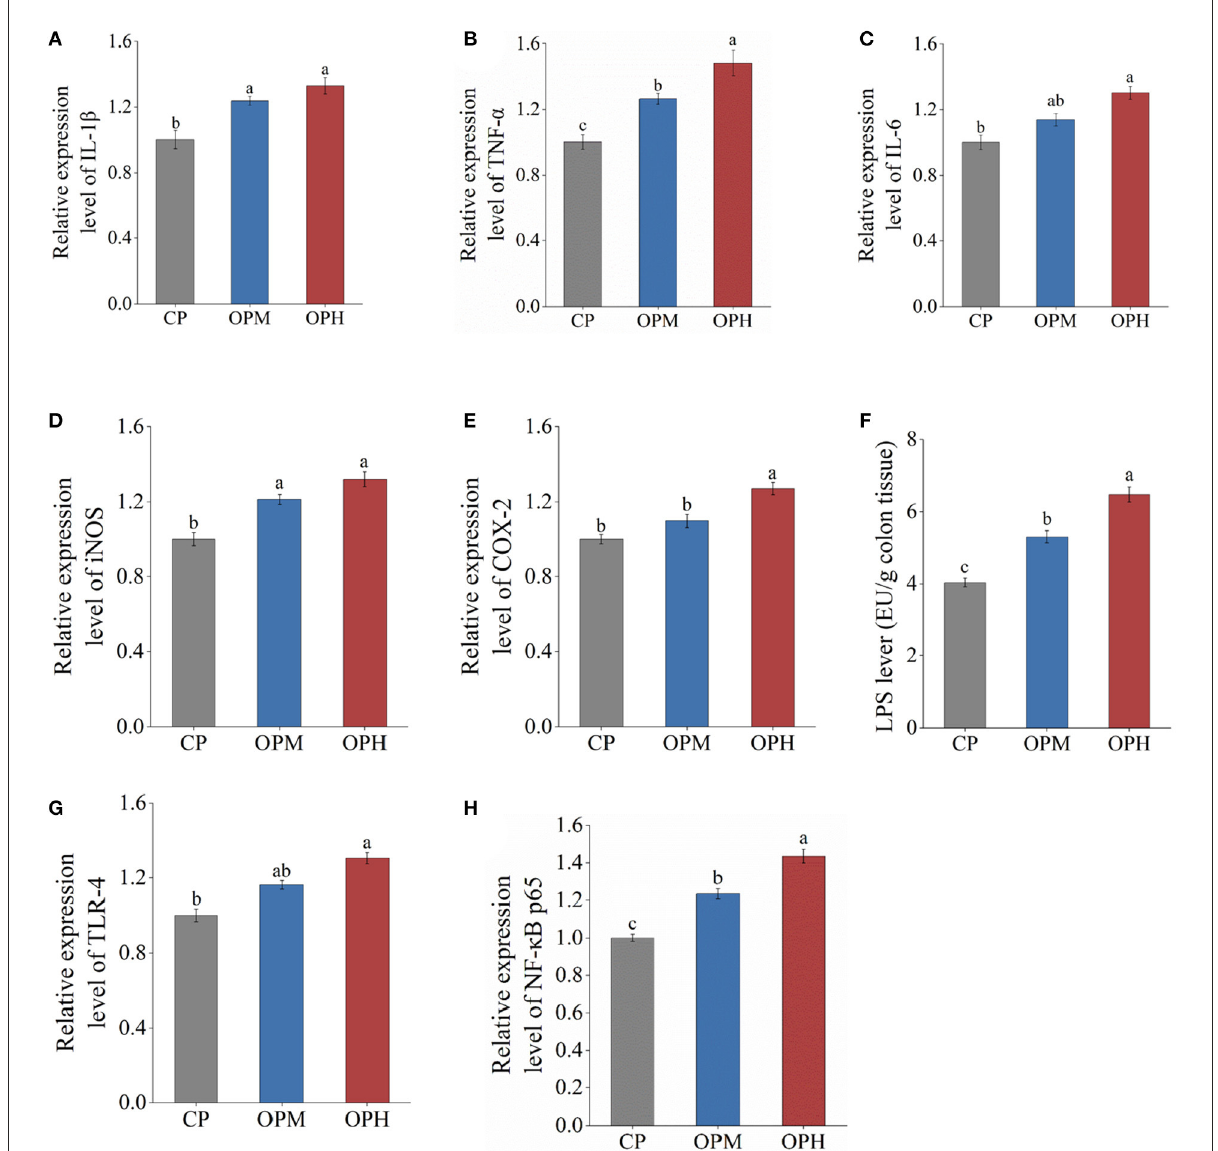
FIGURE7 Effects of consuming oxidized beef protein on proinflammatory factors. (A) IL-1 β ; (B) TNF- α ; (C) IL-6; (D) iNOS; (E) COX-2; (F) LPS; (G) TLR-4; (H) NF- κ B p65. Different letters (a-c) represent significant differences ( p < 0.05). The results were expressed in means ± SEM ( n =